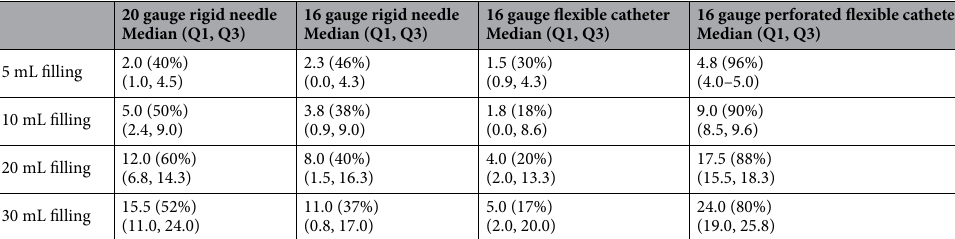
Table 1. Amount of fluid aspirated (mL). n = 10 (5 mL, 10 mL); n = 9 (20 mL, 30 mL); Q1 = 25% quartile, Q3 = 75%